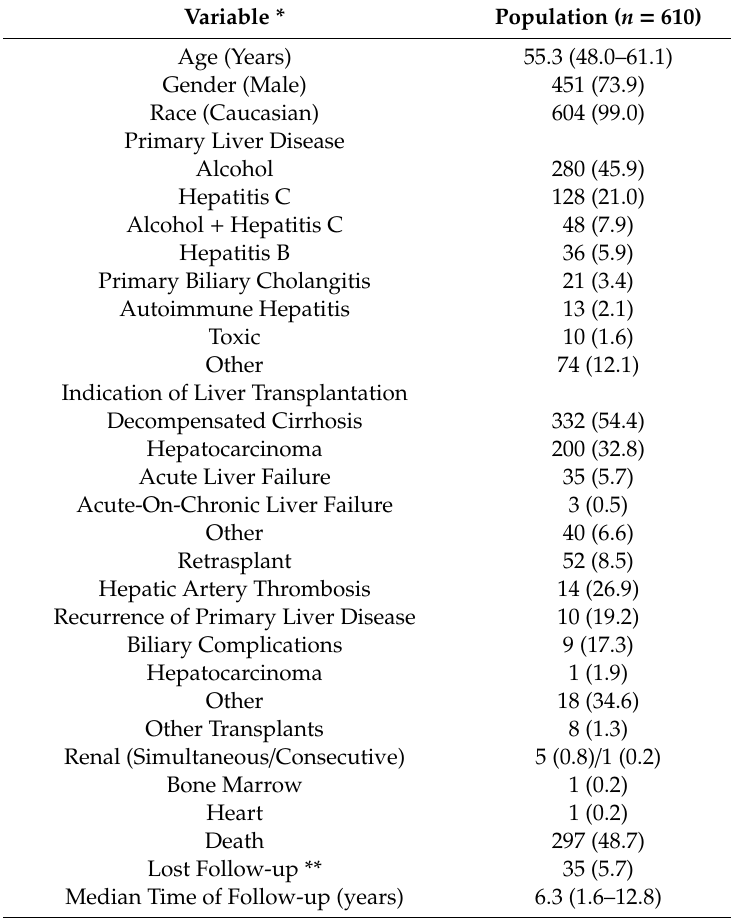
Table 2. Baseline characteristics of liver transplant